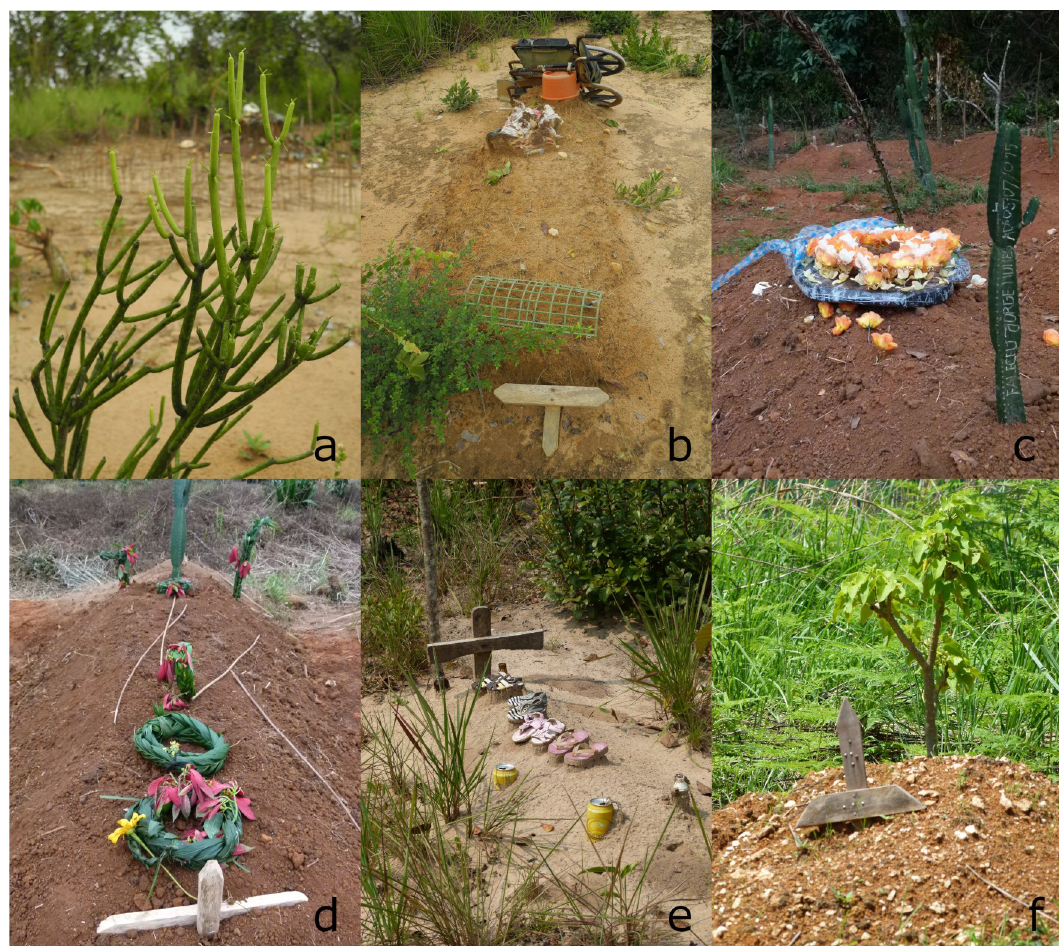
Fig 2. Plants on graveyards in Uı´ge province. (a) Euphorbia tirucalli , the succulent stems branch in regular intervals, in the background another BaKongo graveyard, (b) Graveyard of a handicapped man, decorated with his wheelchair, (c) E . cf. ingens and artificial flowers, (d) garland made of palm leaves and flowers of Euphorbia pulcherrima and Tithonia diversifolia , (e) Children’s shoes, (f) Jatropha curcas and a wooden cross with nails probably showing elements of the BaKongo cosmogram. were provided by leaves or stems (green), 38% by the flowers and in just of one species the red fruits were used for decoration ( Alchornea cordifolia (Schumach. & Thonn.) Mu¨ll.Arg.). Most of the “green” species, representing six out of the seven most abundant species, show a peculiar iterative or spiral growth instead of color. Species with spiral growth forming a rosette are Agave sisalana , Cordyline fruticosa (L.) A.Chev., Dracaena fragrans and Elaeis guineensis Jacq [52]. Here, the leaves are clustered tightly together. Iterative growth patterns are characterized by self-similar branching of highly similar segments. For example, in the most abundant spe- cies, Euphorbia tirucalli , the succulent stems branch at regular intervals (Fig 2A). Alien plants A high number of documented species (59%) is not native to mainland Africa. 14 of these 16 species originated from Central- or South-America; one species was introduced from Asia ( Cordyline fruticosa ) and one from Madagascar ( Catharanthus roseus ). No significant differ- ence between growth form and origin could be detected (chi-square test, P > 0.05). Even if we